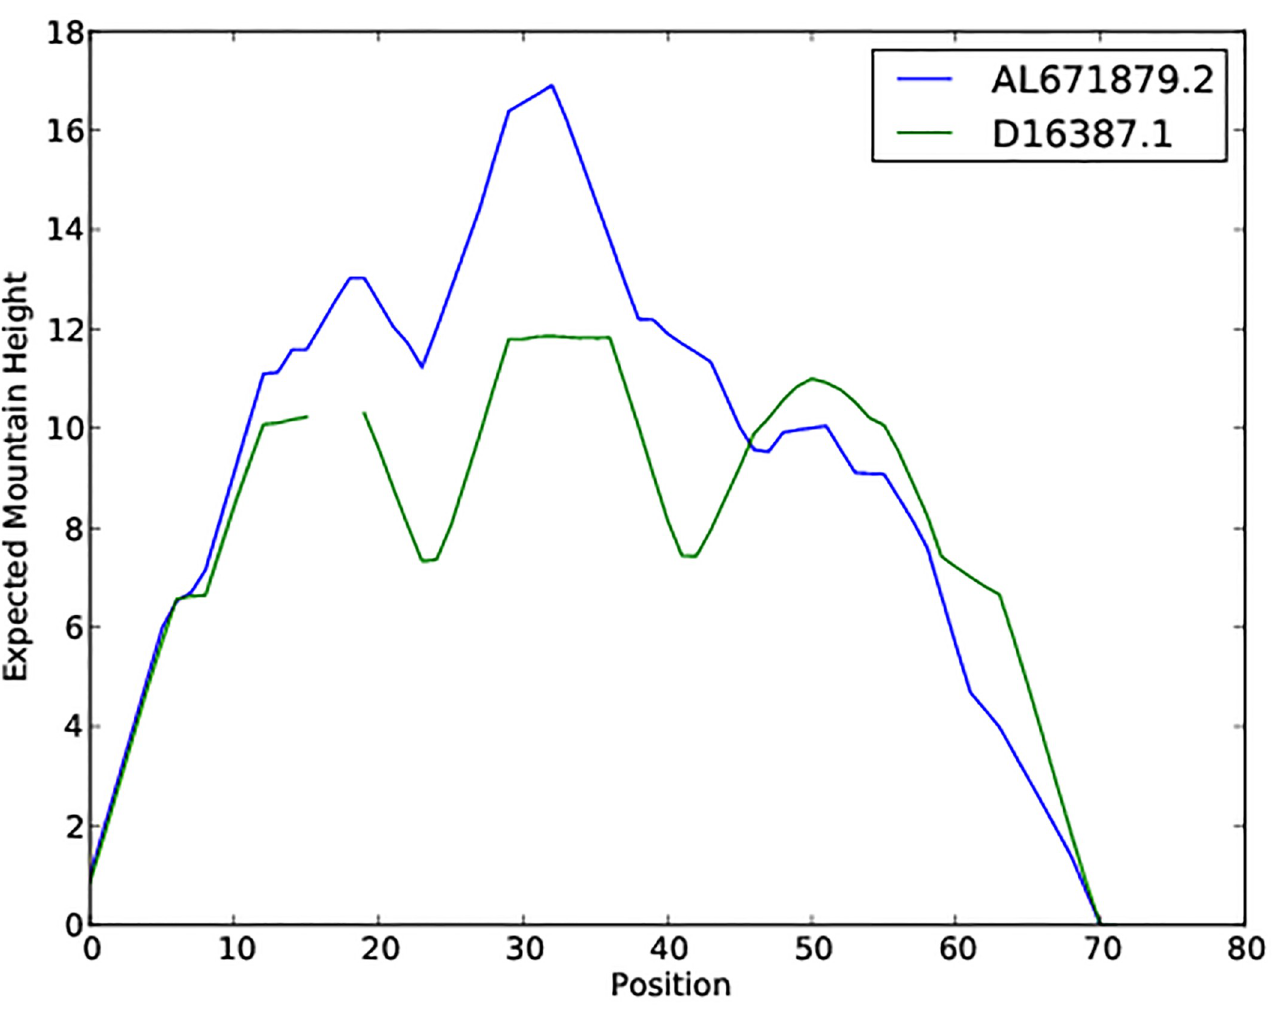
Fig 1. Ensemble mountain height display of the alignment computed by RNAmountAlign for 72 nt tRNA AL671879.2 and 69 nt tRNA D16387.1, both taken from BRAliBase 2.1 K2 , using default gap parameters of − 3 for gap initiation and − 1 for gap extension, and structural weight γ = 1/2. The alignment produced by RNAmountAlign is identical to the reference alignment from BRAliBase 2.1 K2 , although sequence identity is only 28% (twilight zone). The gap in the D16387.1 curve above corresponds to the size 3 gap in the alignment described in the